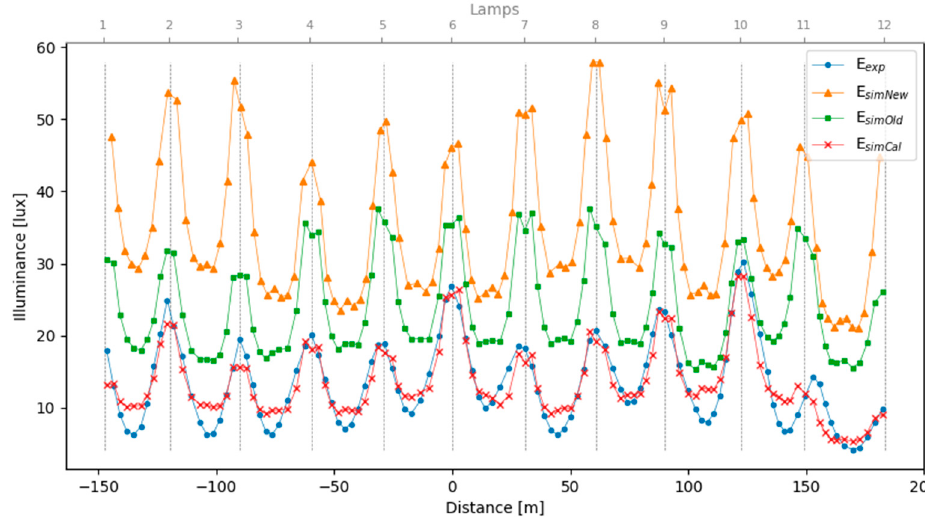
Figure 7. Illuminance at the points of the sample analyzed. ( E exp : experimental illuminance; E simCal and E simOld : simulated illuminance after and before calibration; and E simNew : simulated